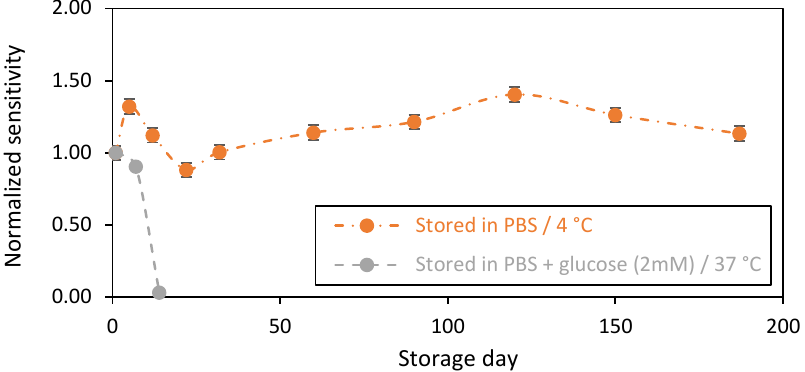
Figure 4. Stability in function of time of the chitosan-based biosensing membranes deposed on gold screen-printed electrodes. Orange plot: biosensors stored in PBS at 4 °C, and grey plot: PBS + glucose (2 mM) at 37 °C (average value and standard deviation on 2 sensors).